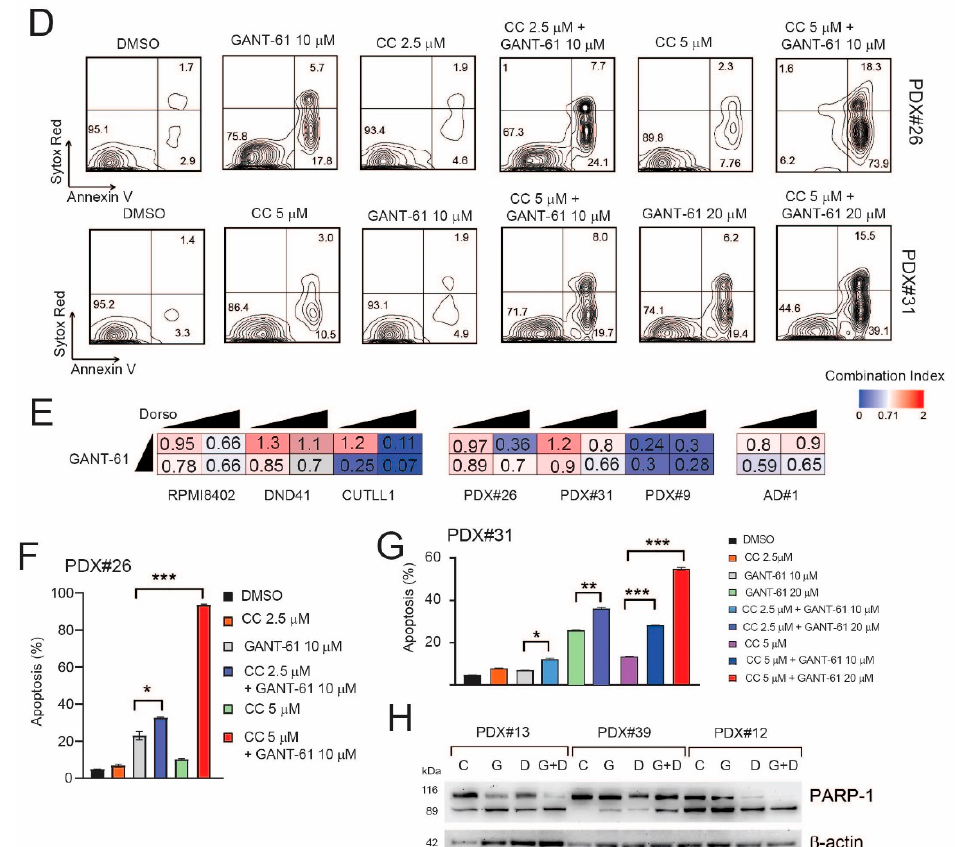
Figure 5. Pharmacological inhibition of AMPK increases the cytotoxic effects of GANT-61 in T-ALL cells. ( A , B ) Representative plots of apoptosis in DND41 ( A ) or Jurkat ( B ) T-ALL cells treated in vitro for 48 h with DMSO (vehicle), Compound C (CC) only (2.5 µ M), GANT-61 only (20 µ M), or CC + GANT-61. ( C ) Representative plots of apoptosis in patient-derived xenograft (PDX#13) T-ALL cells treated in vitro for 48 h with DMSO (vehicle), Compound C (CC) only (2.5 µ M), GANT-61 only (10–20 µ M, PDX#13), or CC + GANT-61. ( D ) Representative plots of apoptosis in patient-derived xenograft (PDX#26, #31) T-ALL cells treated in vitro for 48 h with DMSO (vehicle), Compound C (CC) only (2.5–5 µ M), GANT-61 only (10–20 µ M), or CC + GANT-61. ( E ) Heat map representation of combination indexes between GANT-61 and Compound C (CC) in T-ALL cell lines (RPMI8402, DND41, CUTLL1), patient-derived xenografts (PDX#26, #31, #9), and patient-derived leukemic cells (AD#1). GANT-61 was used at 10 or 20 µ M, while Compound C was used at 2.5 or 5 µ M. CI > 1.1 indicates antagonism, CI < 1 indicates synergism. ( F ) Quantification of apoptosis in PDX#26 treated in vitro for 48 h with DMSO (vehicle), Compound C (CC) only (2.5 or 5 µ M), GANT-61 only (10 or 20 µ M), or combinations of CC + GANT-61. Results of one of two experiments (with similar results) performed in triplicate are shown. Results are shown as the mean ± SD. * p < 0.05, *** p < 0.001. ( G ) Quantification of apoptosis in PDX#31 treated in vitro for 48 h with DMSO (vehicle), Compound C (CC) only (2.5 or 5 µ M), GANT-61 only (10 or 20 µ M), or combinations of CC + GANT-61. Results of one of three experiments (with similar results) performed in triplicate are shown. Results are shown as the mean ± SD. * p < 0.05, ** p < 0.01, *** p < 0.001. ( H ) Western blot evaluating the expression levels of PARP-1 in PDX samples (#13, #39, #12) treated in vitro for 48 h with DMSO (vehicle; C), Compound C (D) only (2.5 or 5 µ M), GANT-61 only (G; 10 or 20 µ M), or combinations of CC + GANT-61 (G + D). β -actin was used as loading